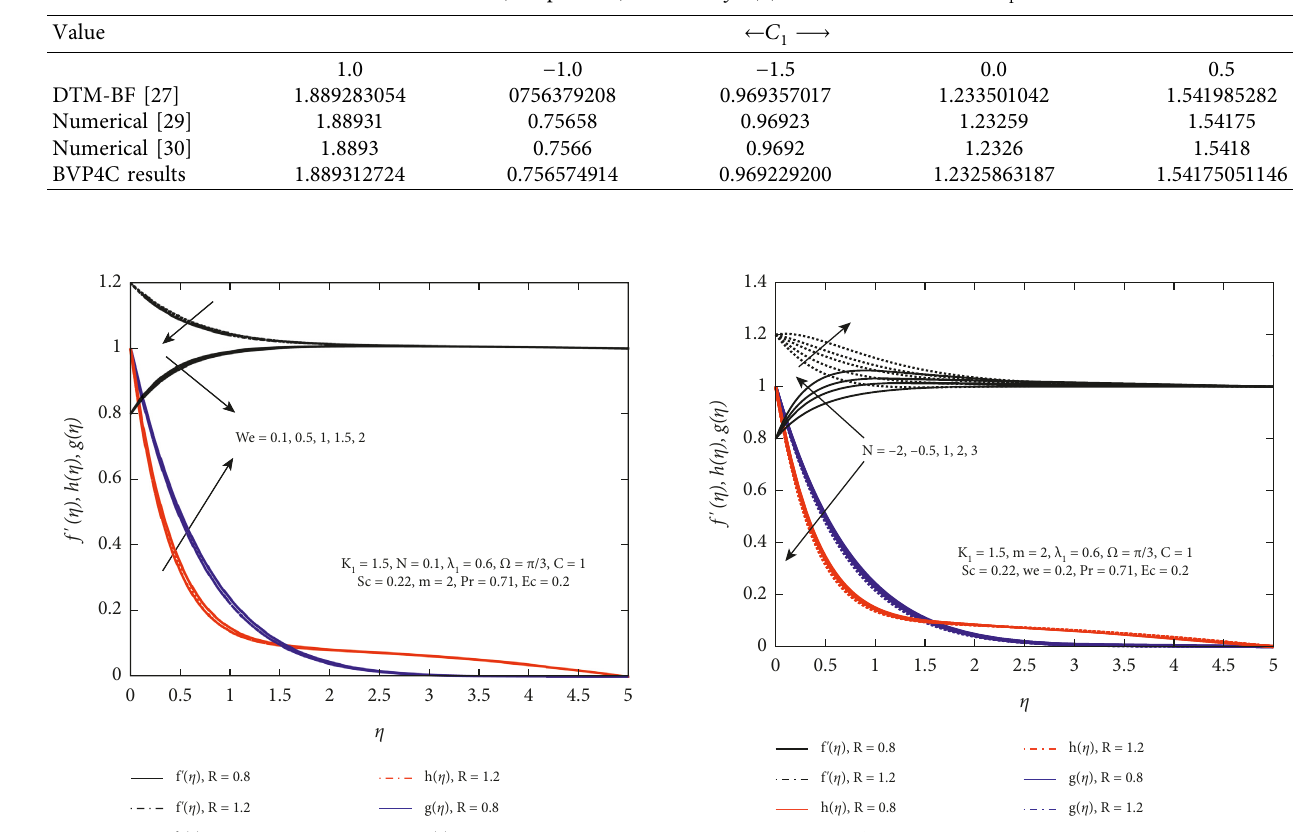
, h ,g η η η for growing values of N. ( ) ( ) ( ) ′